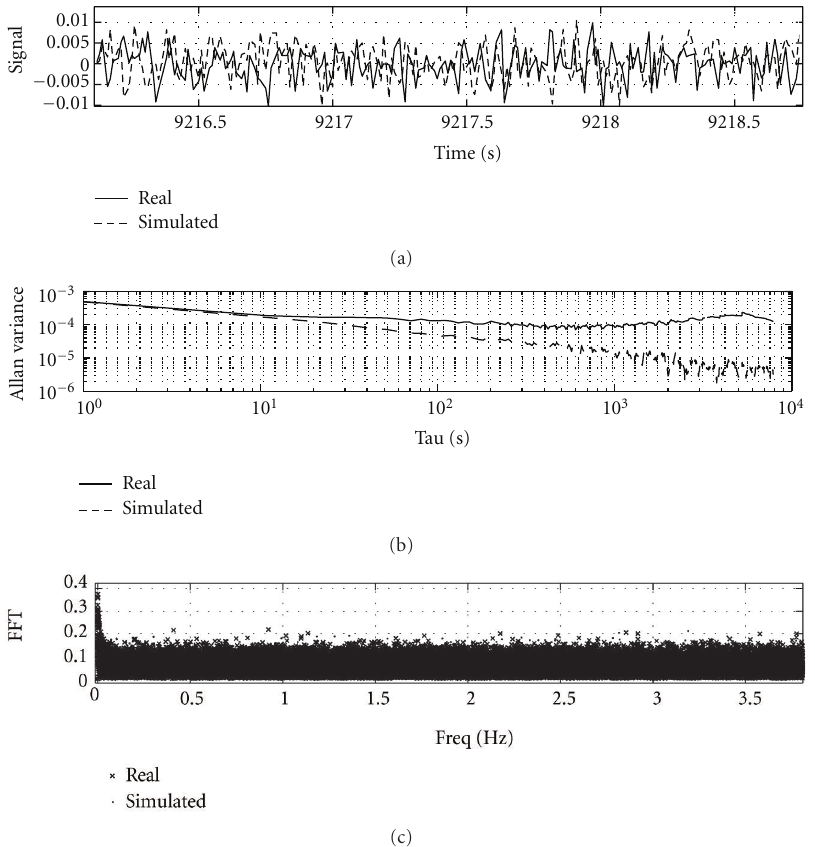
Figure 9: Comparative results for real and simulated IMU sensor error for X l acceleration, in g (Earth acceleration of gravity at sea level). (a) Window of the time series ( g ). (b) Allan variance plot ( g ). (c) FFT of time series ( g 2